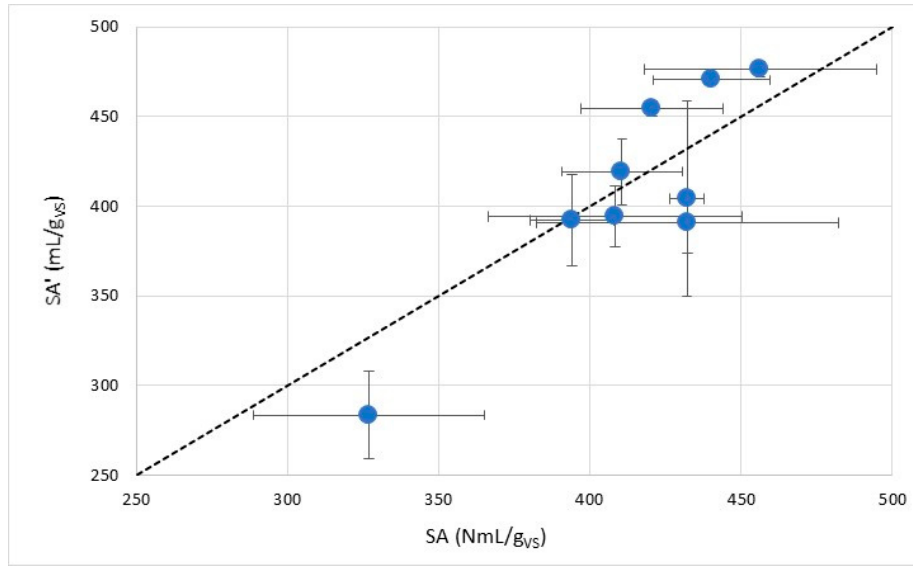
Figure 6. Scatterplot SA vs SA’, mean values and standard deviation for each lab.